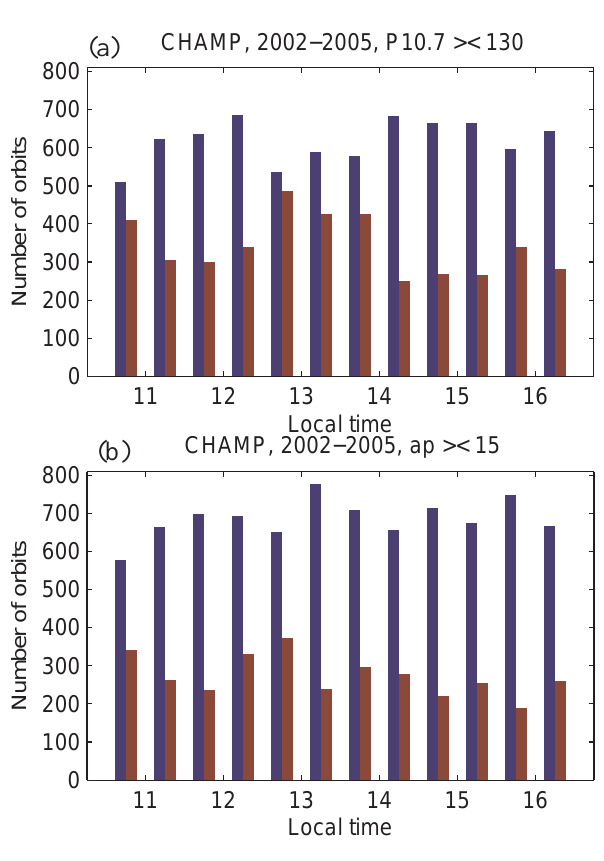
Fig. 1. Sample distribution of the considered density values over the relevant local times in half-hour bins. Counts are shown for high (red) and low (blue) (a) solar flux, P10.7, periods and (b) magnetic activity, a p ,